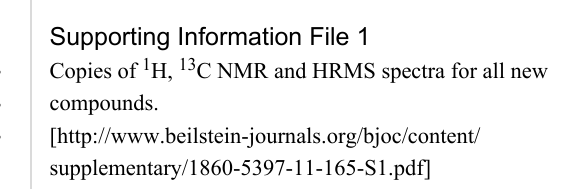
Compound 5a: Pale yellow oil, 110 mg (70%), by using the general procedure 100 mg (0.33 mmol) of dione 3a was converted into bisindole derivative 5a . IR (neat): 738, 1267, 2934, 3055, 3357, 3690, 3945 cm − 1 ; 1 H NMR (500 MHz, CDCl 3 ) δ 1.83 (t, J = 6.50 Hz, 4H), 2.15–2.16 (m, 4H),